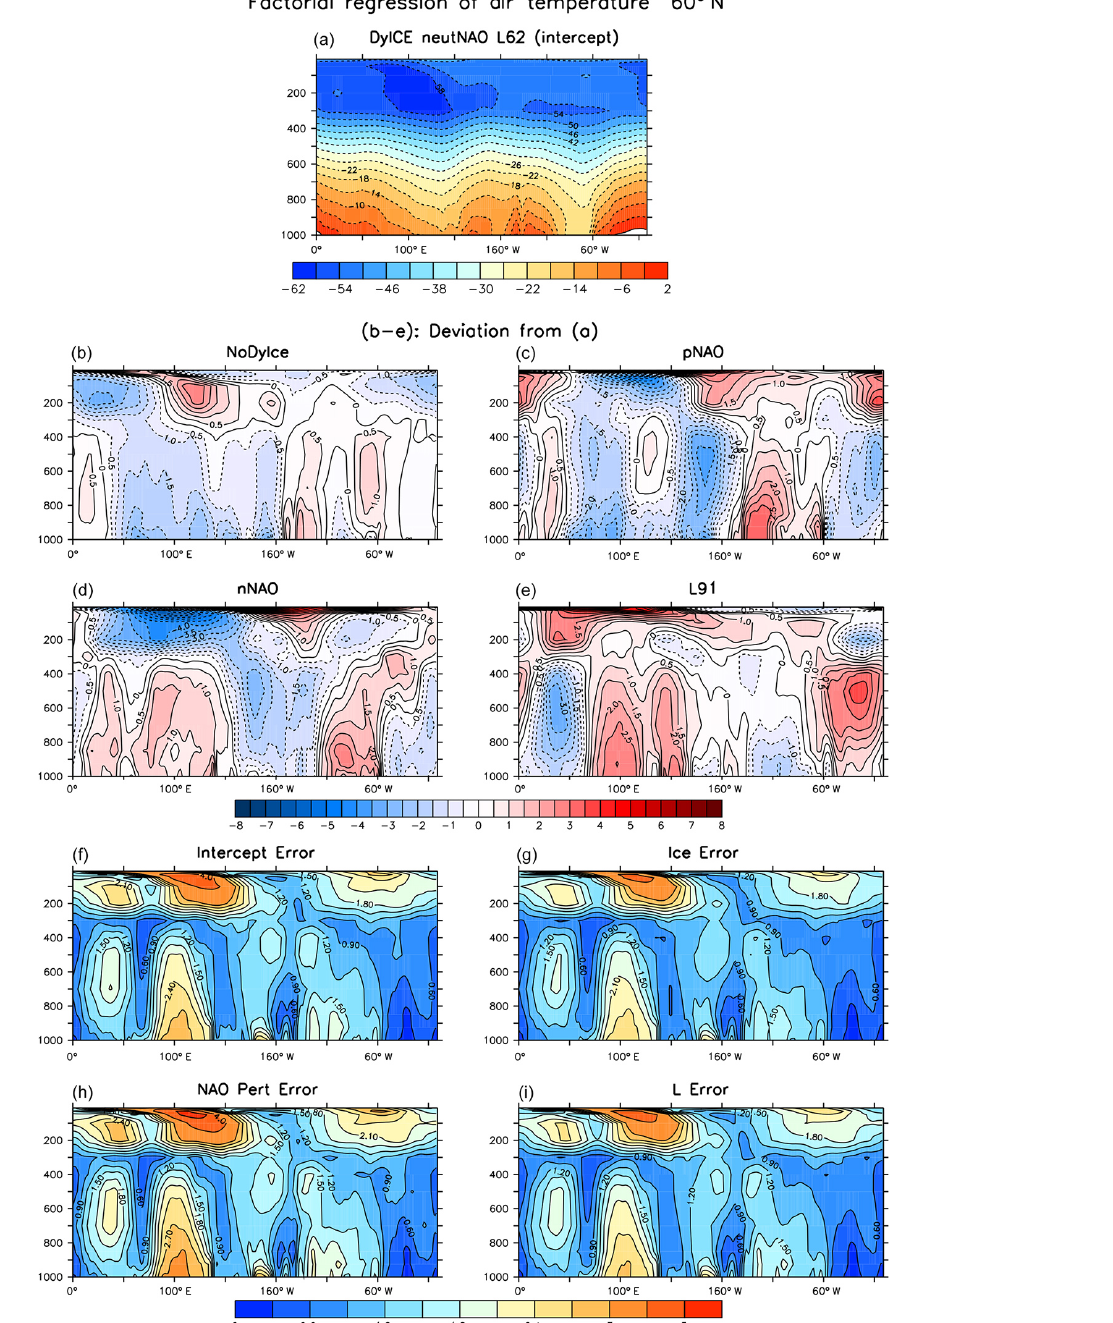
Figure 2. Coefficients and error estimates from the factorial regression of air temperature at 60 ◦ N. These results describe the systematic differences associated between the different choices in the model